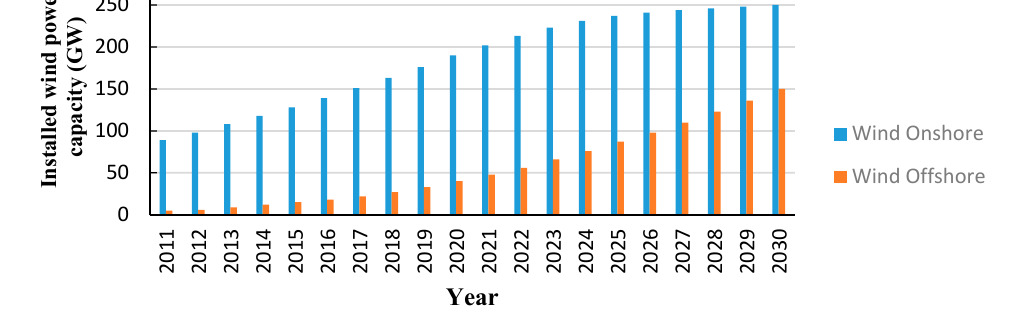
Figure 1. European wind power forecast for 2030.